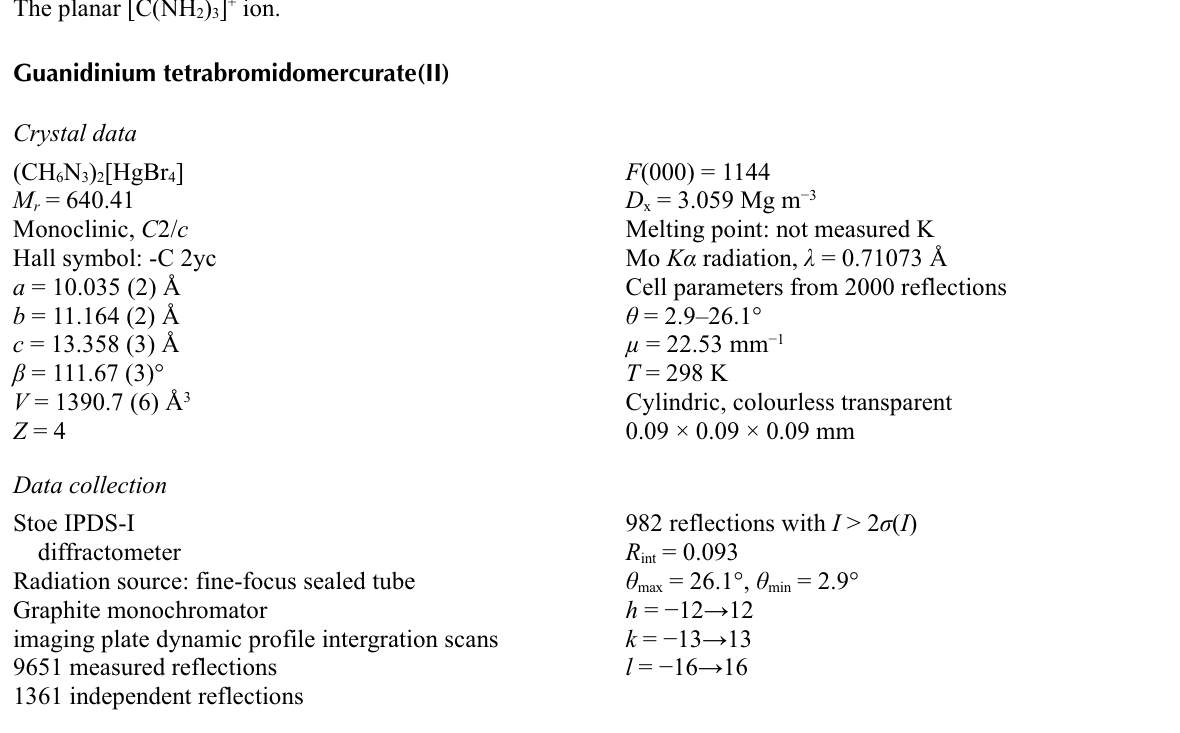
The planar [C(NH